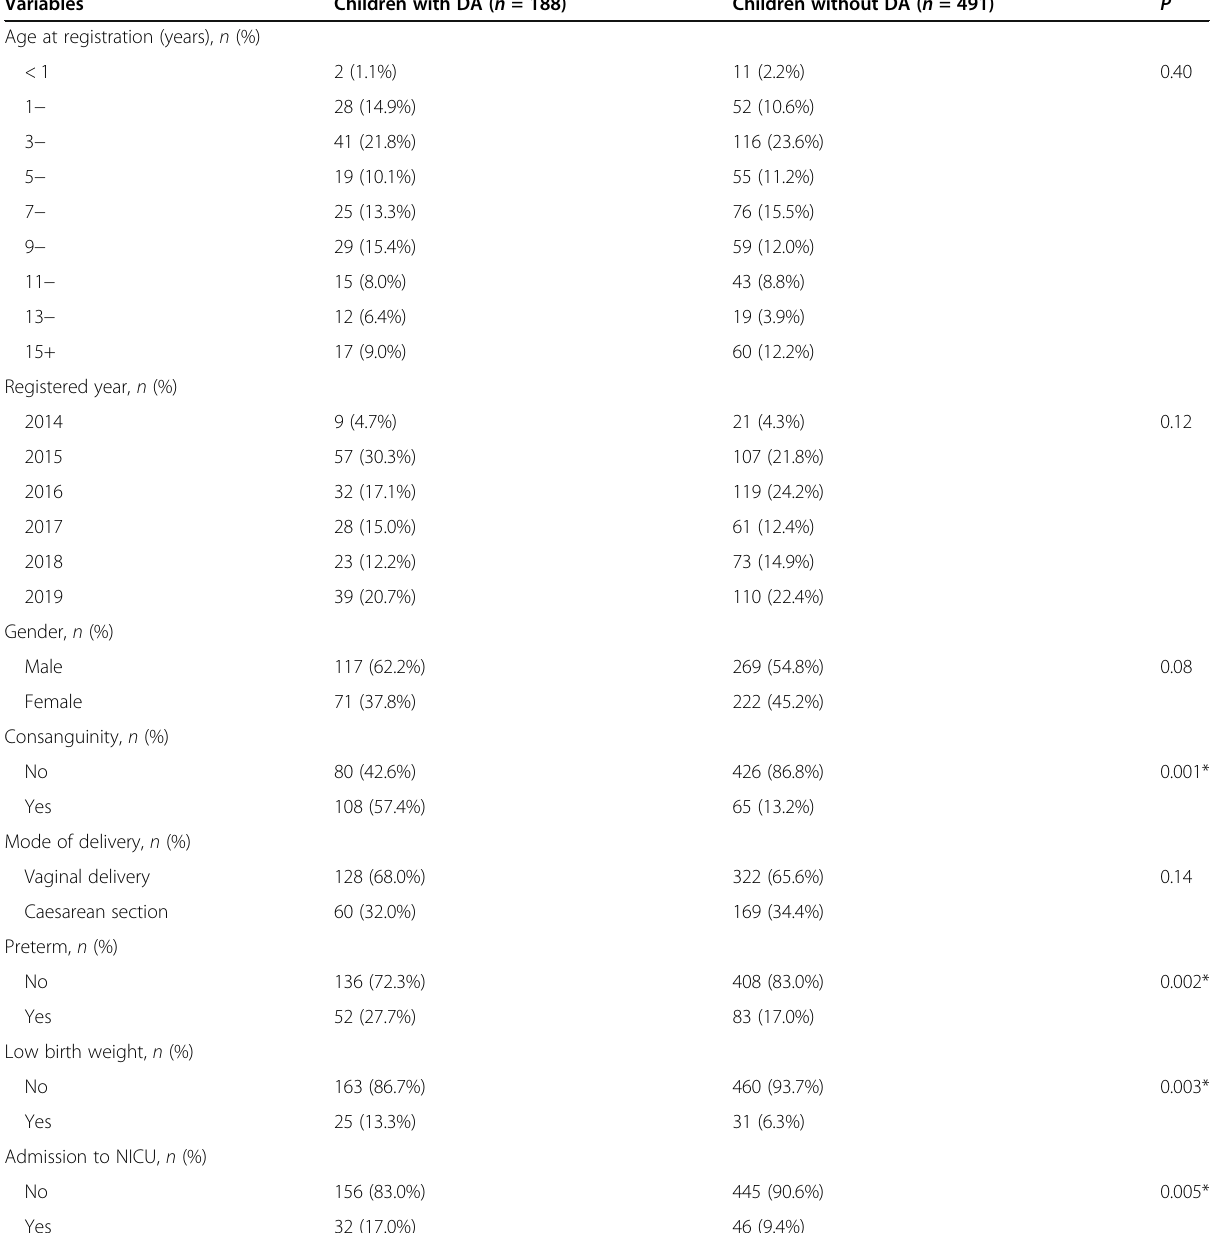
Table 1 Demographic, perinatal, and postnatal data among children with cerebral palsy (CP) Variables Children with DA ( n = 188) Children without DA ( n = 491)